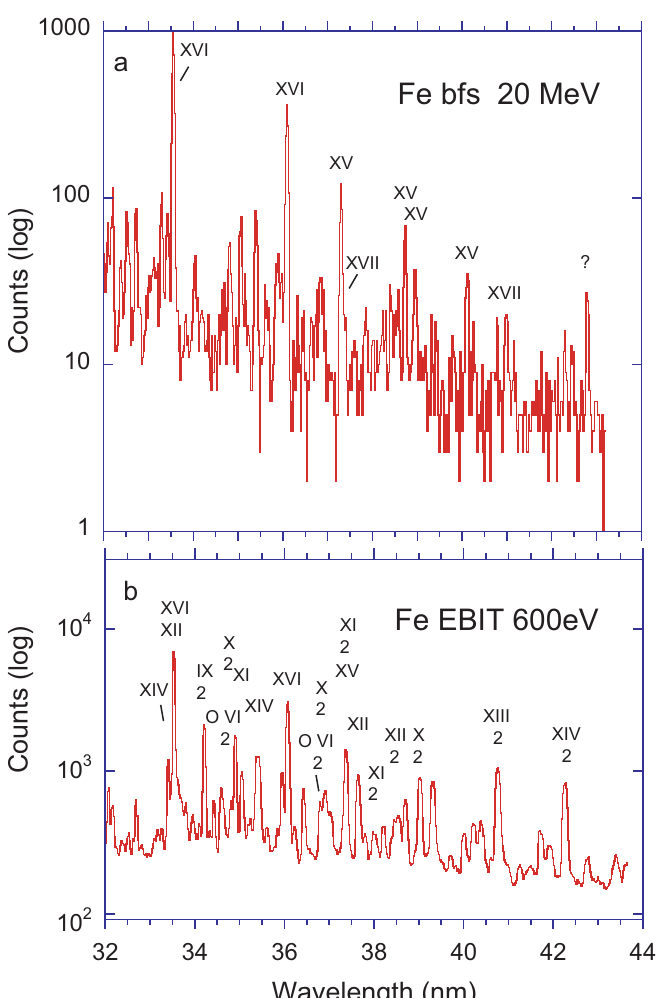
Figure 15. Fe spectra observed with ( a ) the beam–foil light source [104] and ( b ) in an electron beam ion trap (see [28,29]). The beam–foil spectrum of Fe has been recorded at an ion beam energy of 20 MeV. Slit width 80 µ m, line width (FWHM) 0.06 nm. The charge state distribution is centered on q = 11 + , and ion charge states q = 8 + to q = 14 + are expected to contribute. The EBIT spectrum has been obtained at an electron beam energy of 600 eV. The strongest lines are identified by the spectrum number. Line labels including an Arabic numeral ‘2’ indicate a line in second diffraction order; several O V and O VI lines appear and serve for wavelength calibration. ( a ) continues Figure 14a, ( b ) Figure